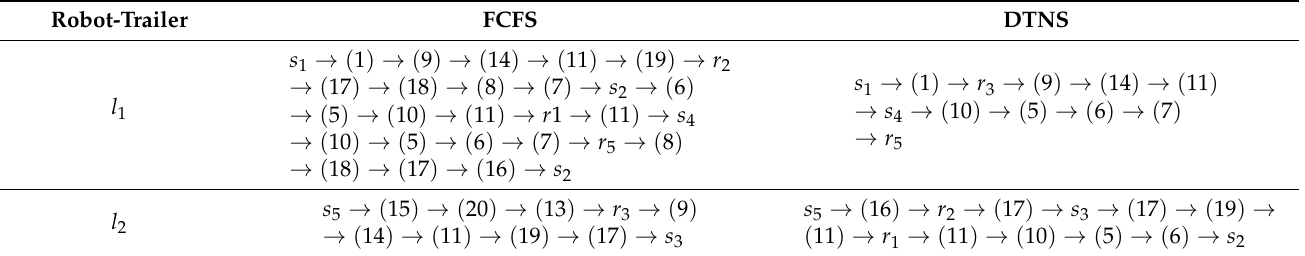
Table 11. Paths obtained by FCFS and DTNS under the condition of two robot-trailer in scenario 2. Robot-Trailer